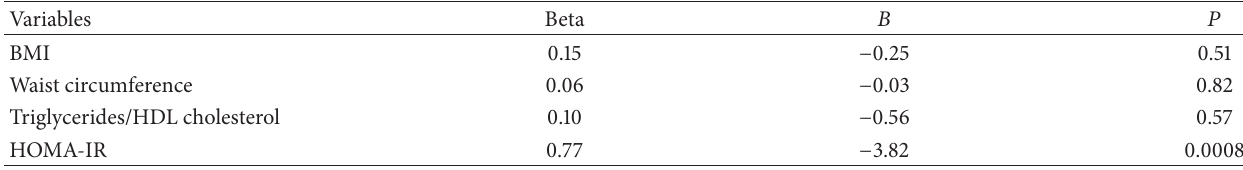
Table 4: Multivariate regression analysis for dependent variable fasting glucose in women with both pt2dM and a history of GDM. Variables